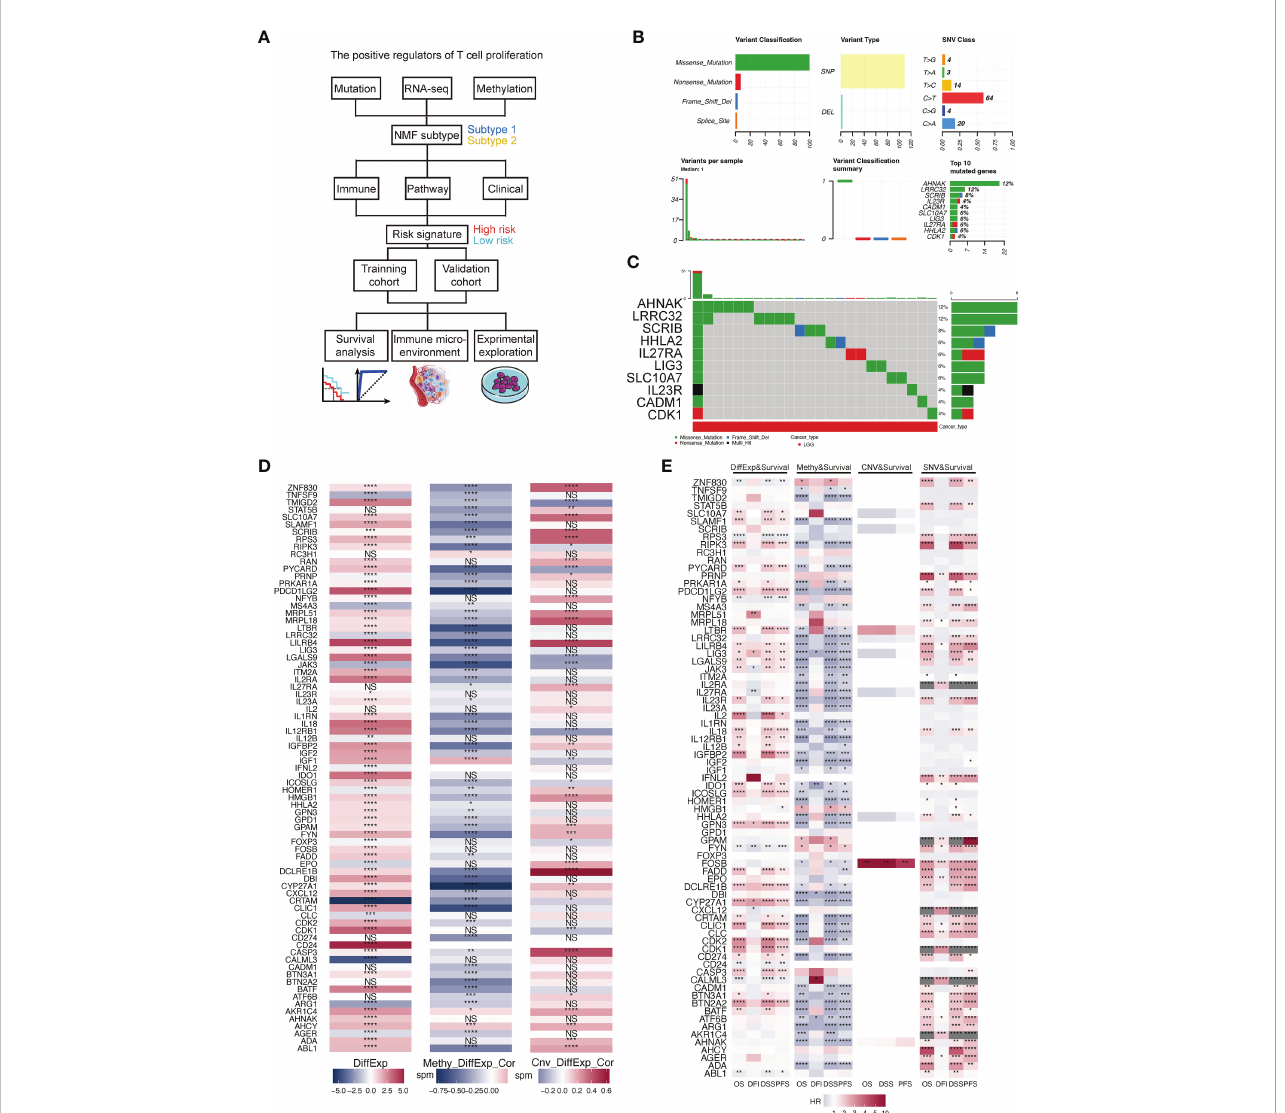
FIGURE 1 (A) Flowchart of this study. (B) A summary of the single nucleotide variants (SNV) of TPRs in TCGA-LGG cohorts. (C) A landscape of the genomic status of TPRs in TCGA-LGG cohorts. (D) The correlation between the differential expression of TPRs and methylation level/copy number aberration (CNA) status; DiffExp, log2 fold change of differential expression; Methy_DiffExp_Cor, the correlation between the methylation level of TPRs and TPR expression; Cnv_DiffExp_Cor, the correlation between CNA status and TPR expression. (E) The correlation among TPR expression and four survival estimate methods; OS, overall survival; DFI, disease-free interval; DSS, disease-speci fi c survival; PFS, progress-free survival. *p<0.05, **p<0.01, ***p<0.001, ****p<0.0001, ns: no signi fi cant